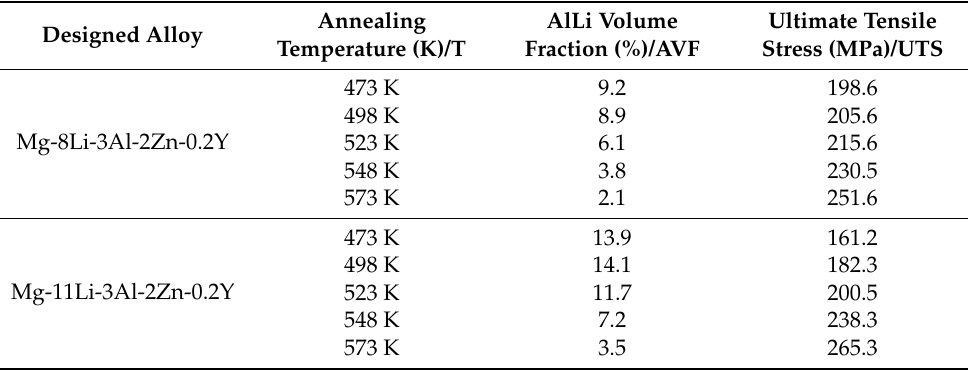
Table 2. Strength and AlLi volume fraction at different